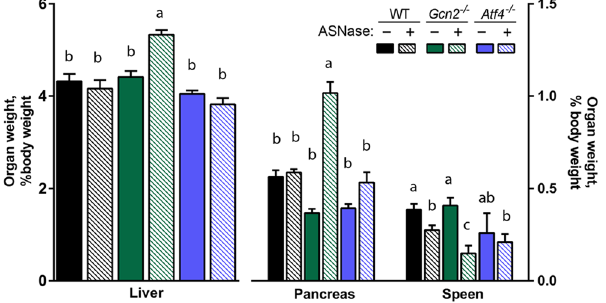
Figure 1. Percent weight change of liver, pancreas, and spleen relative to body weight following 8 daily injections of asparaginase (3 IU per gram body weight, ASNase) or phosphate buffered saline excipient (PBS) in wild type mice (WT) or mice deleted for Gcn2 ( Gcn2 − / − ) or Atf4 ( Atf4 − / − ). Data are represented as the average value ± standard error of the mean, n = 4–6 animals per group. Means not sharing a letter are different according to Tukey post hoc analysis following ANOVA, P <